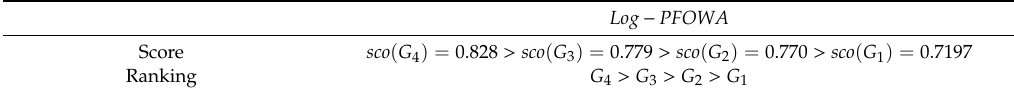
Table 13. Evaluation results of each air station.